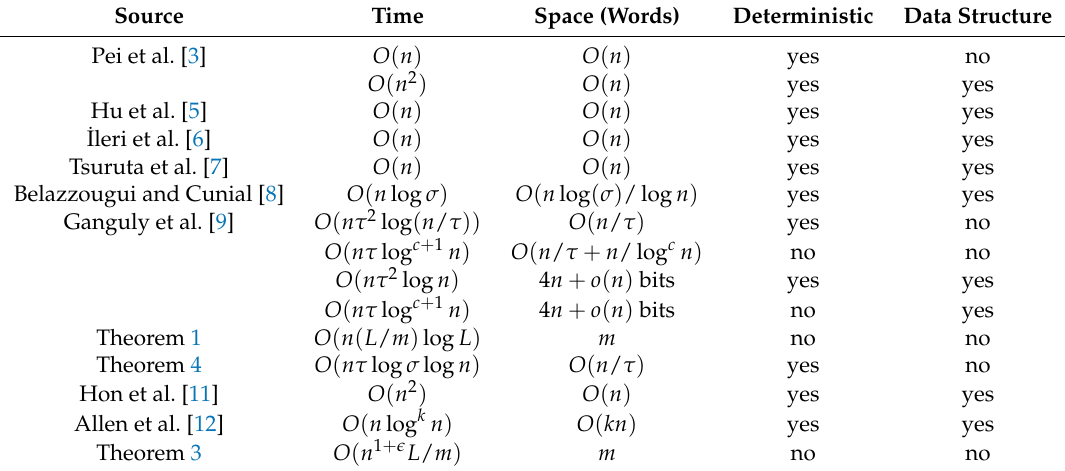
Table 1. Previous bounds and our results for finding SUSs (the first twelve results) and k -mismatch SUSs (the last three), where n is the length of the text, σ is the alphabet size, L is the length of the SUS or k -mismatch SUS, and m , τ < n and c are parameters. Theorem 3 is Monte Carlo and we require m = ω ( n (cid:101) ) , so that the probability of failure can be made inversely proportional to any fixed polynomial of n . All of the data structures return an SUSs given q in O ( 1 ) time and have the same final space as construction space, except that the construction-space bounds for Ganguly et al.’s third and fourth results are O ( n / τ ) words plus 4 n + o ( n ) bits of space, and O ( n / τ + n / log c n ) words plus 4 n + o ( n )